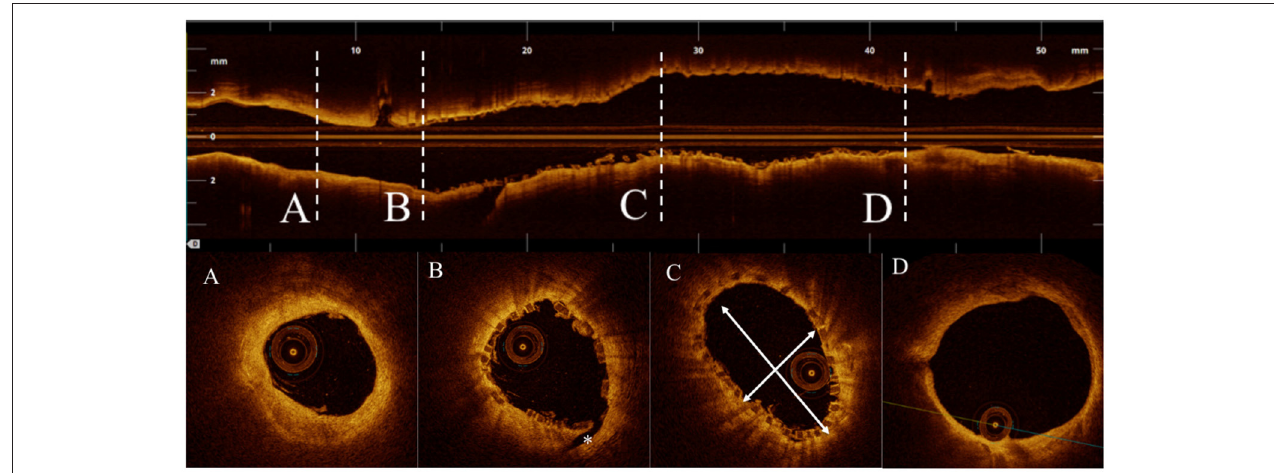
FIGURE 1 | (A) Distal reference vessel area (DRVA) = 3.77 mm 2 . (B) Asterisk indicating a distal edge dissection. (C) Cross section with minimum eccentricity index (minimum/maximum diameter) = (2.29/3.96mm) = 0.57. (D) Proximal reference vessel area (DRVA) = 11.59 mm 2 . Reference vessel area (RVA) = (PRVA + DRVA)/2 = (11.59 + 3.37 mm 2 )/2 = 7.48 mm 2 .